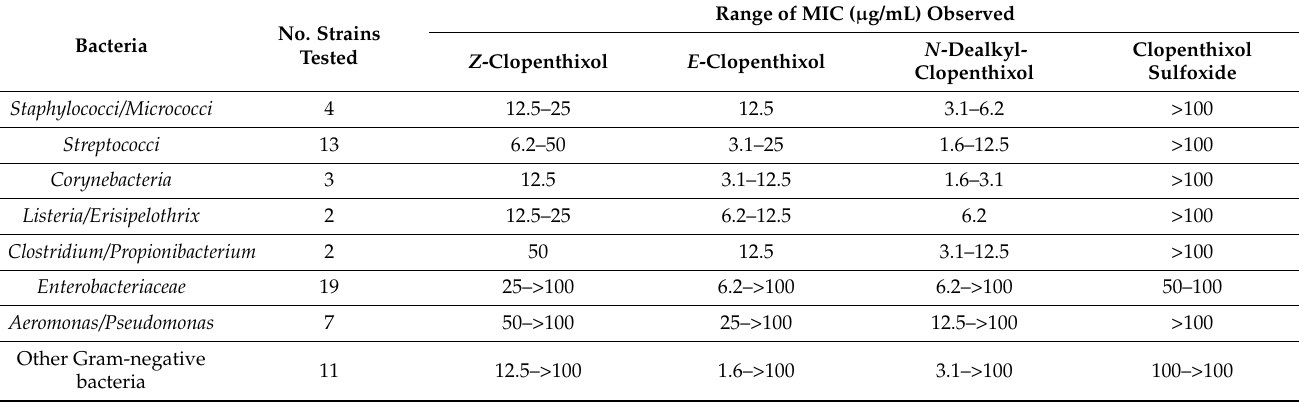
Table 3. Antibacterial effect of two stereo-isomeric forms of clopenthixol and its metabolites.